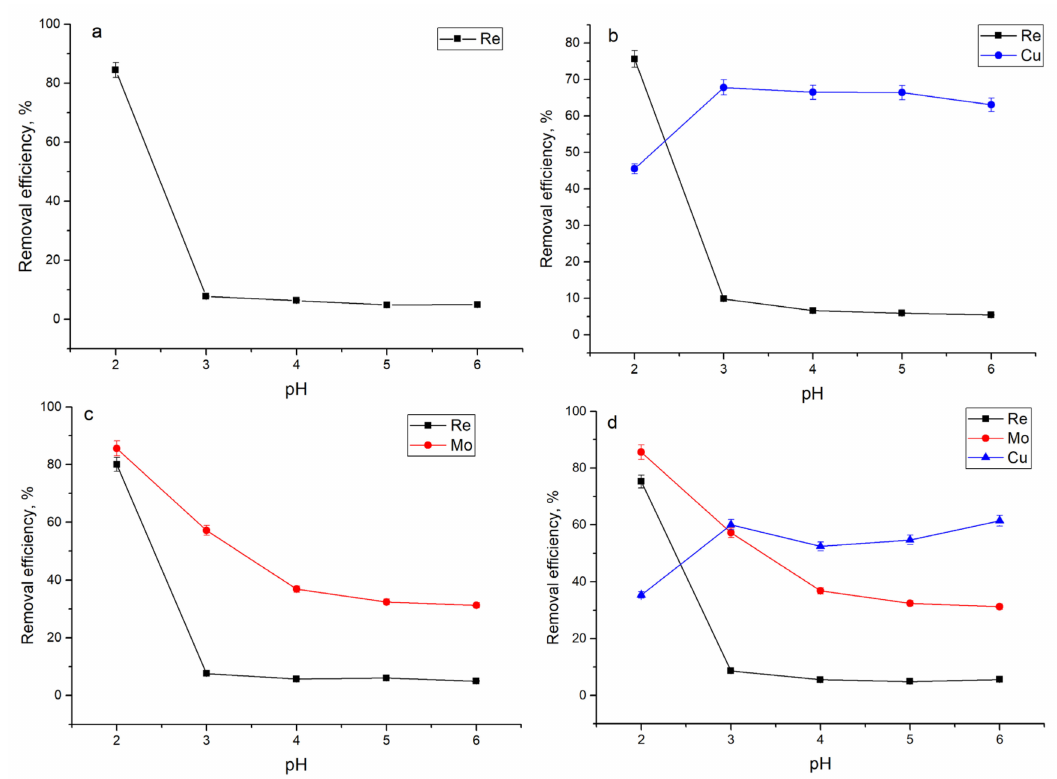
Figure 2. Effect of initial solution pH on the adsorption of metal ions present in analyzed systems: ( a ) Re, ( b ) Re-Cu, ( c ) Re-Mo, and ( d )